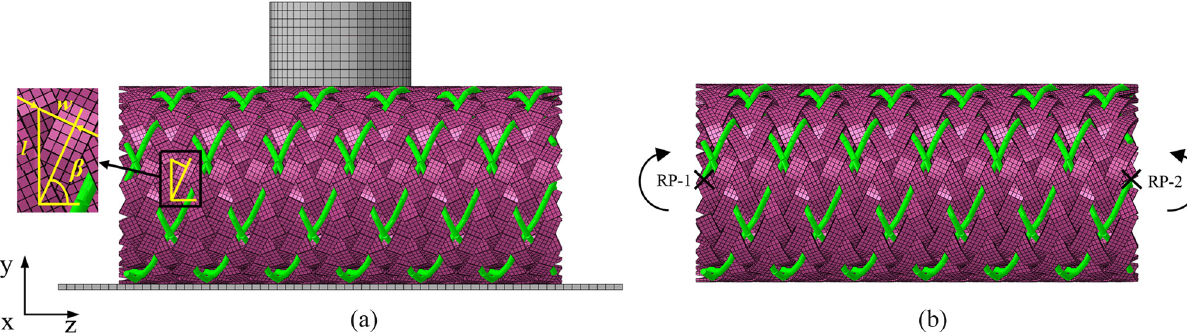
Figure 1: Three - dimensional model of BCS: ( a ) compression test and ( b ) bending